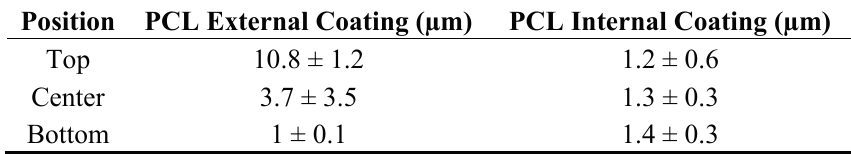
Figure 5. ESEM image of a magnesium PCL implant. Two different zones of the PCL coating were analyzed, named the external coating and the internal coating. Table 2. Coating thickness depending on the position of